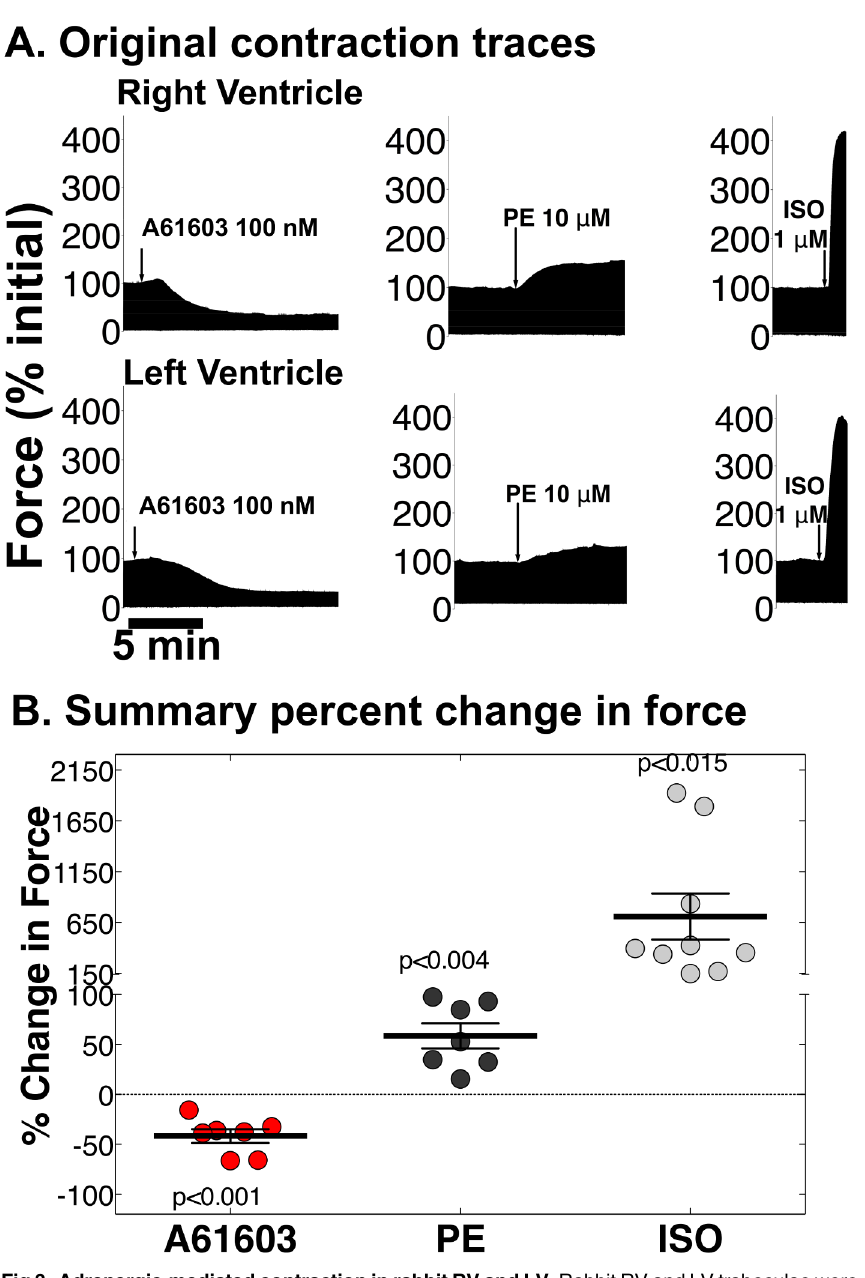
Fig 3. Adrenergic-mediated contraction in rabbit RV and LV. Rabbit RV and LV trabeculae were mounted, perfused, and electrically stimulated in vitro at 1.5 hz and 37°C. Contraction was measured after addition of A61603 (100 nM), the selective α 1A-AR agonist; PE (10 μ M), a nonselective α 1-AR agonist; or ISO (1 μ M), a non-selective β -AR agonist. ( A ) Original contraction traces; and ( B ) group data combining for each agonist 4 – 5 RV trabeculae and 3 – 4 LV trabeculae. Values are mean ± SE. Note split Y